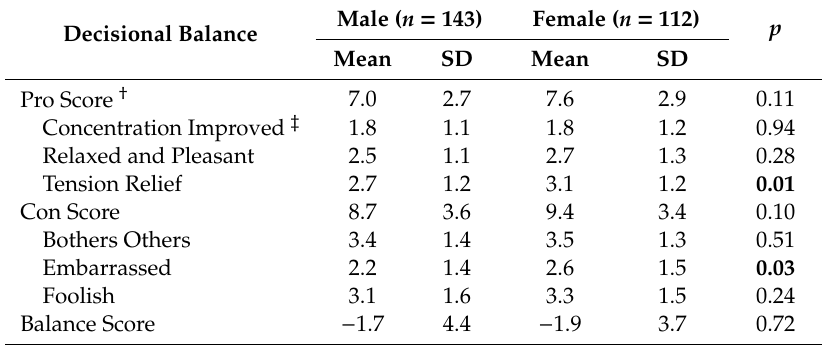
Table 2. Decisional Balance and Response Items by Gender, BOLD-Australia